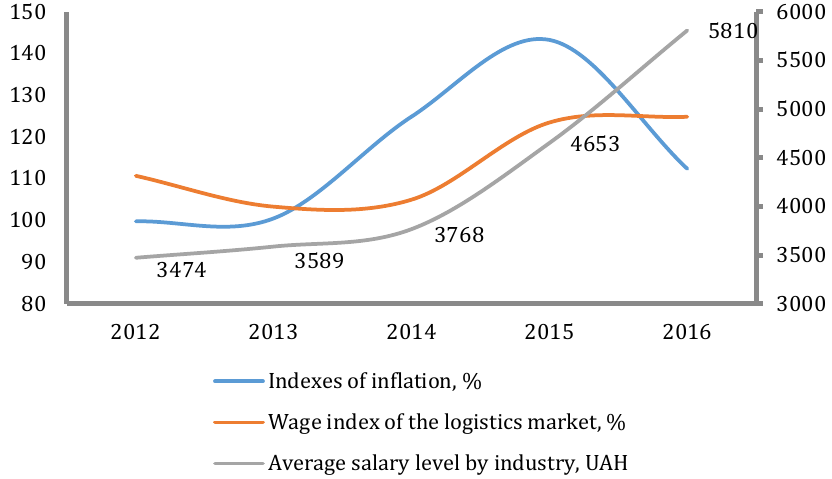
Figure 3: Dynamics of wages in the logistics industry